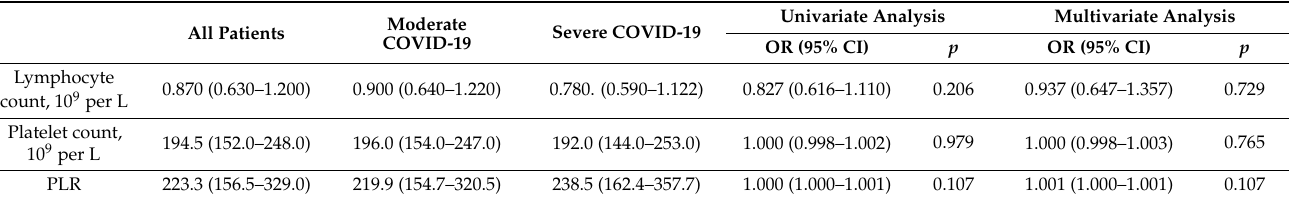
Table 3. Univariate and multivariate analyses for risk factor for COVID-19